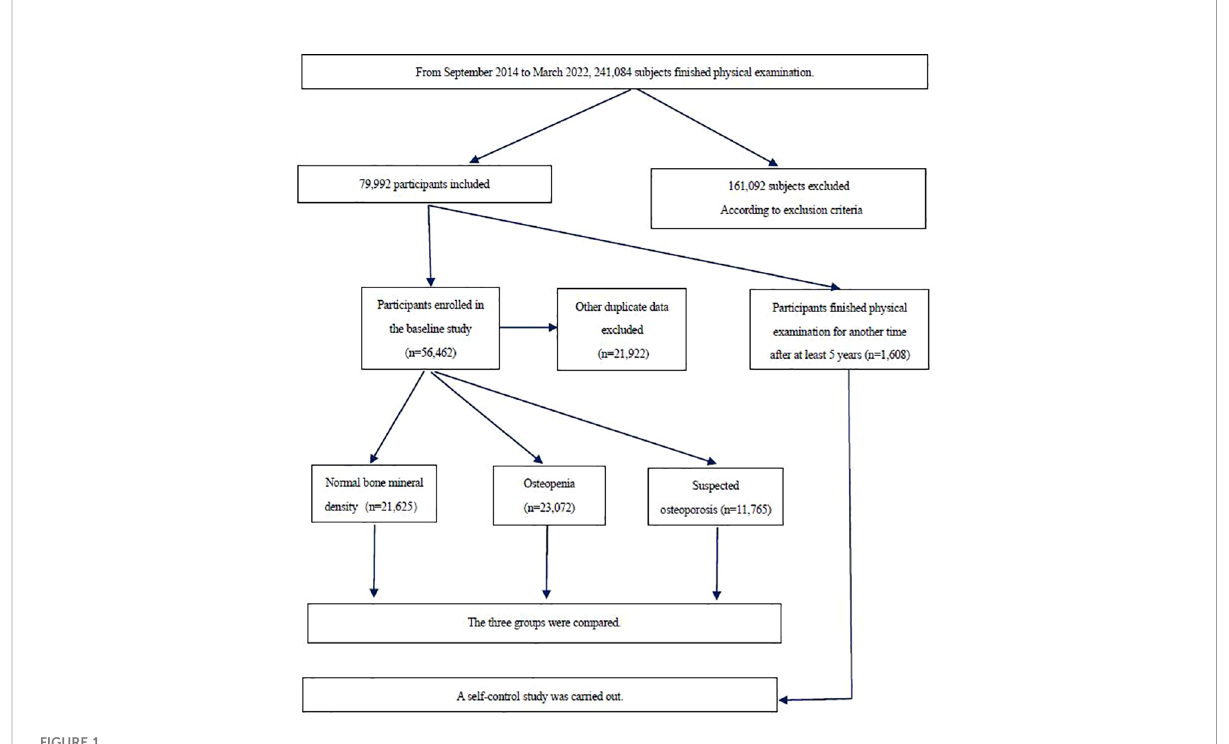
FIGURE 1 Flow chart of the study